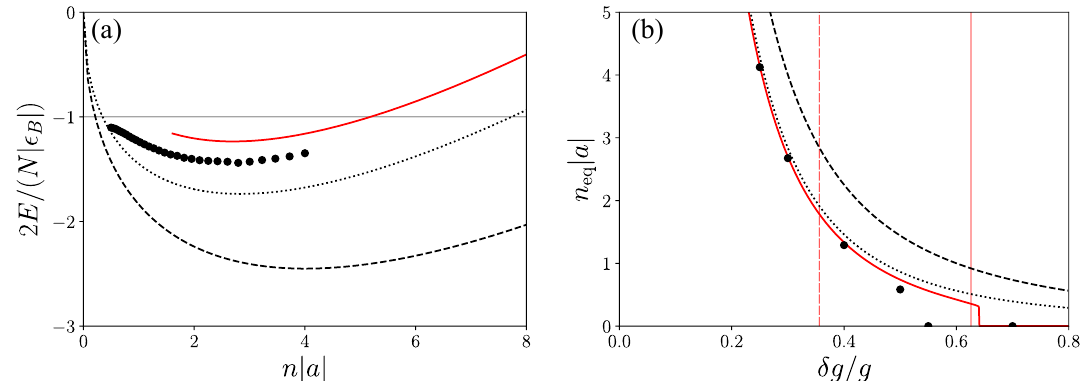
Figure 7: (a) Energy per particle of a 1D liquid as a function of density for δ g / g = 0.3. (b) Equilibrium density of the liquid phase as a function of δ g / g . The black dashed line corresponds to prescription (8) of Ref. [ 3 ] while the dotted line is the beyond mean-field result with the Bogoliubov speed of sound Eq. (7). The red solid line is the prediction from our theory. Black dots are the QMC results from Ref. [ 15 ] . The dashed and solid vertical lines in panel (b) indicate the critical values for δ g / g above which the liquid becomes metastable in respect to the molecular gas and atomic gas states,